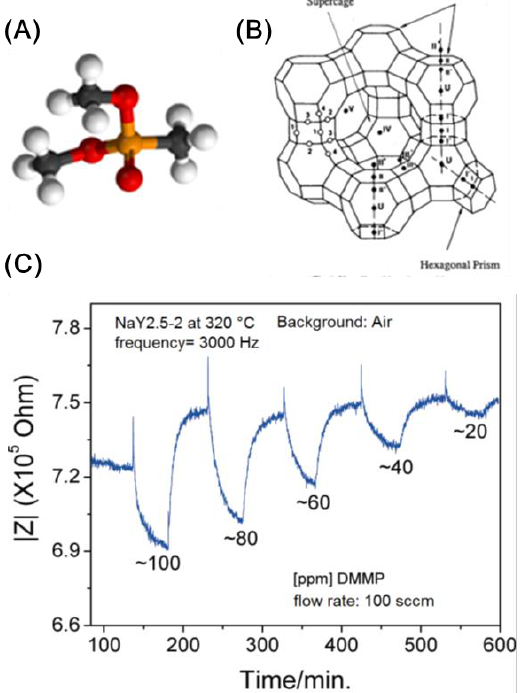
Figure 15. ( A ) Model of dimethylmethylphosphonate (DMMP); ( B ) Zeolite Y supercage with cation positions; ( C ) Change in impedance of Na-zeolite Y with varying concentrations of DMMP (frequency 3,000 Hz) (adapted from Reference